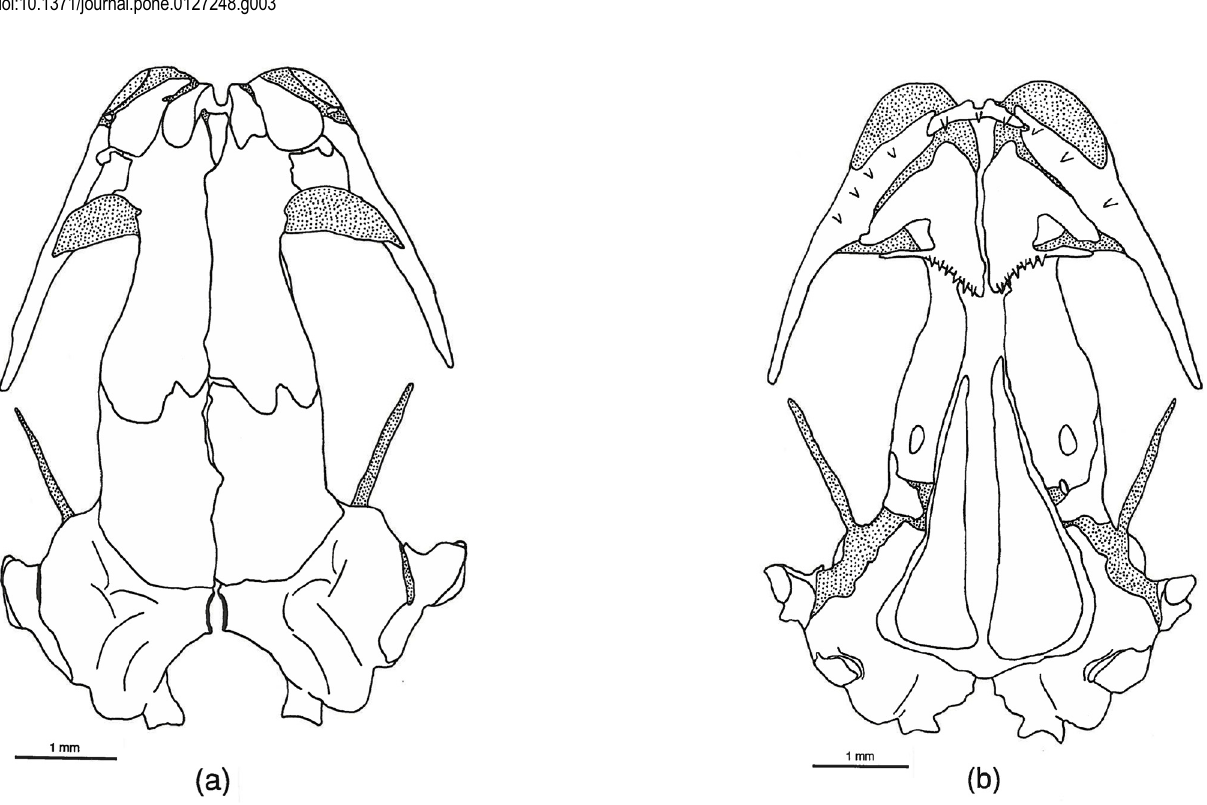
Fig 4. Chiropterotriton lavae skull. Drawings of dorsal (a) and ventral (b) aspects of the skull of Chiropterotriton lavae (MVZ 171898). Stippled areas represent cartilage. Elements as labeled in Fig 1.